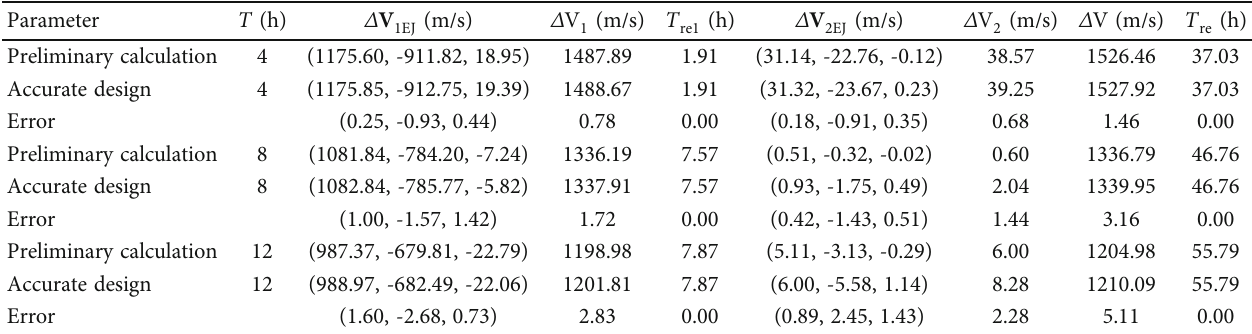
Table 5: The results of the two-impulse abort orbits (when the maximum abort return time is 1.25 times the minimum return time of a single-impulse abort